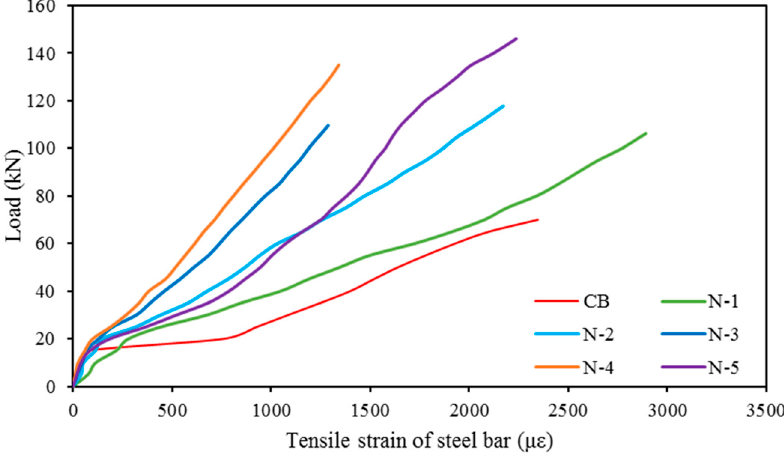
Figure 7. Load vs. tensile strain in main reinforcements at midspan for all beams.